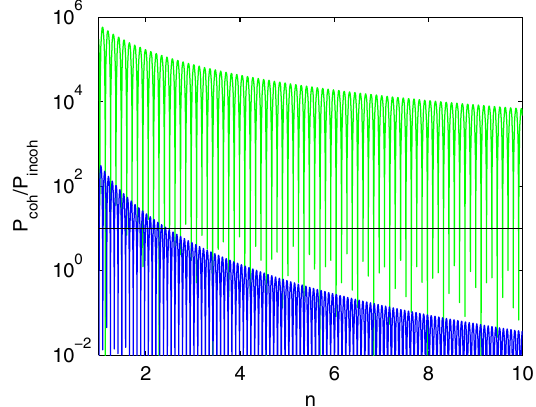
FIG. 5. Ratio of coherent to incoherent power as a function of the decompression factor for a flattop bunch (green) and a parabola shaped bunch (blue). The bunch parameters correspond to the long wavelength case shown in Table I. The detection threshold for an FEL signature of P FEL =P incoh ¼ 10 as proposed in [18] is marked by the solid black line.